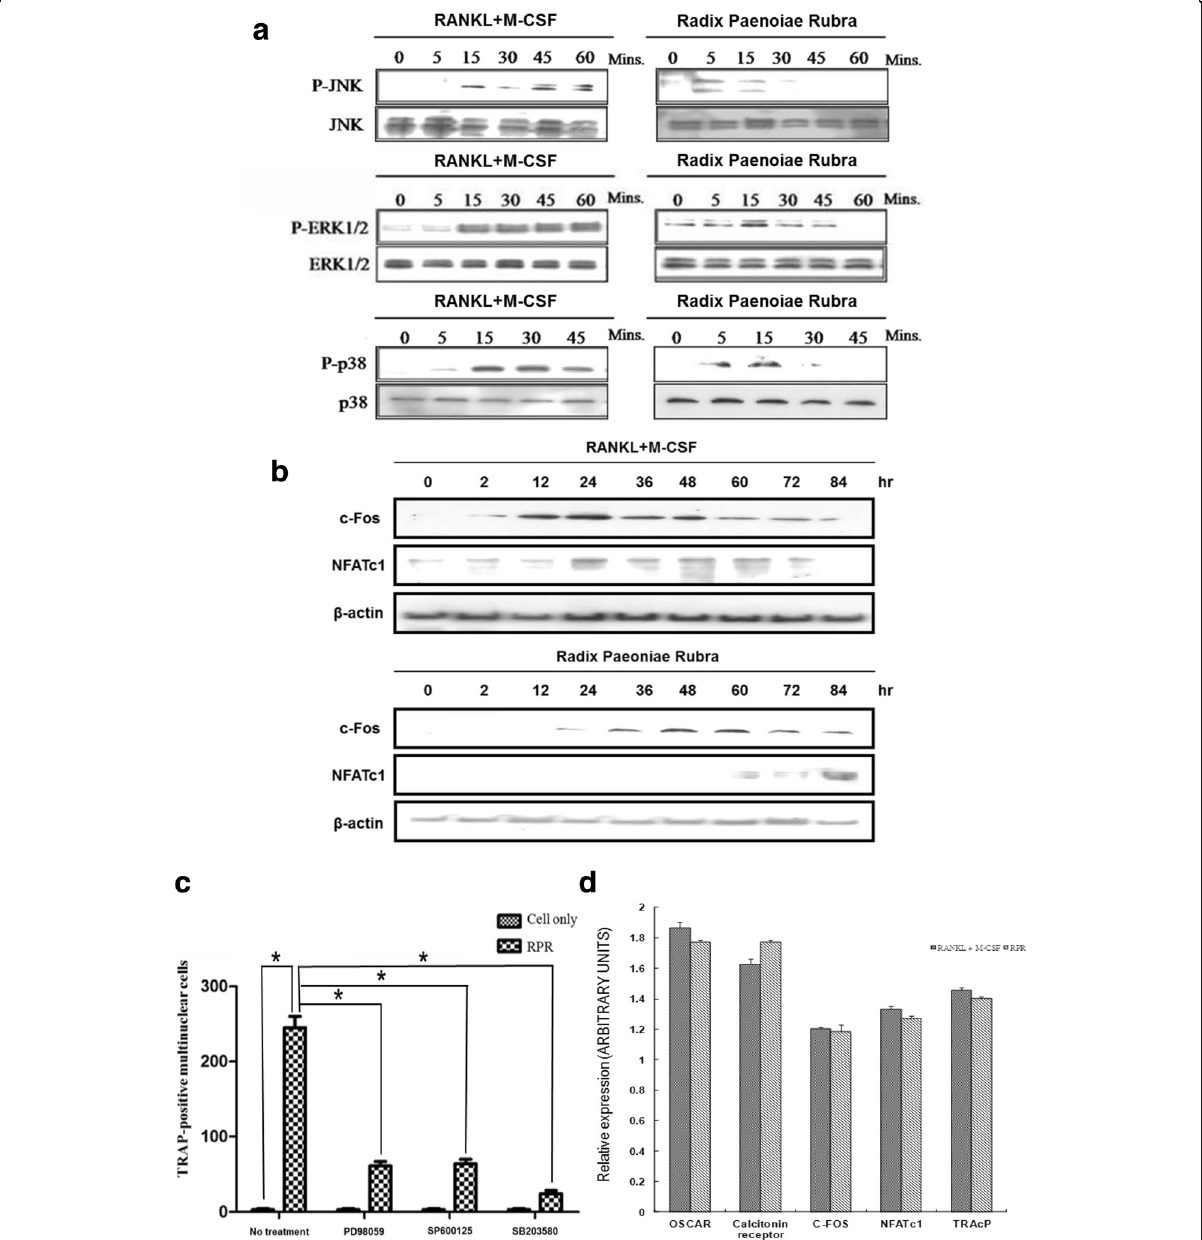
Fig. 2 RPR-induced stimulation of MAP kinases. a RAW264.7 macrophages were subjected for specified time periods to vehicle RPR (10 μ g/ml), or RANKL (50 ng/ml) and M-CSF (25 ng/ml). Cells were then solubilized, and Western blot analysis of p38, JNK, and ERK protein expression was used to examine cell lysates. The top panel of each group shows a trace that denotes the immuno-reactivity of the phosphorylated kinase. The same membrane (shown in the bottom panel) was then exposed and re-probed with the kinase antibody to identify the total kinase protein level. Outcomes represent three separate experiments. b Western blotting with Abs specific for β -actin (control), NFATc1, and c-Fos (all from Santa Cruz Biotechnology) was employed to analyze the lysates collected from cultured cells. c RPR-induced osteoclast formation required stimulation of JNK, p38, and ERK. Prior to activation with M-CSF and RANKL or RPR (10 μ g/ml), RAW264.7 macrophages were pre-treated with vehicle 10 ng/ml SB203580, 10 ng/ml SP600165, or 0.5 ng/ml PD98059 for 20 mins. After culture for 7 days in RAW264.7 macrophages, a TRAP assay was employed on the cells. Data represent the mean ± SD of a minimum of three separate tests; * p < 0.01, RPR treatment versus cell only; # p < 0.01, inhibitor treatment versus no treatment. d The image shows the consequences of RANKL and RPR on osteoclast gene expression. M-CSF (200 ng/ml) and RANKL (100 ng/ml) or RPR (15 μ g/ml) were applied to human monocytes. After culture for 14 days, total RNA was obtained and real-time RT-PCR was conducted for OSCAR, NFATc1, calcitonin receptors, c-fos, and TRAcP. Expression was regulated to that of β -actin; data represent the means ± SD of three repeated